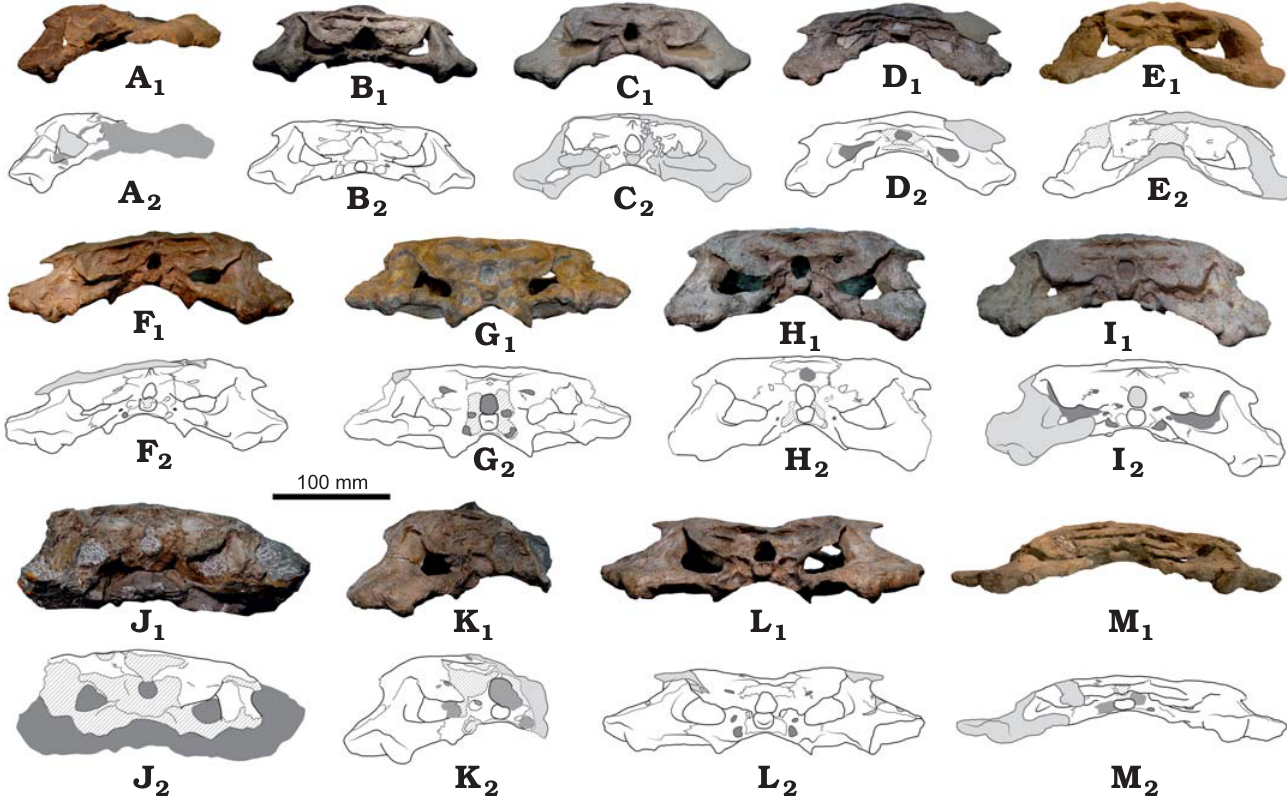
Fig. 5. Skulls of simosaurid sauropterygian Simosaurus gaillardoti Meyer, 1842 from the Ladinian, Middle Triassic of southwestern Germany, in occipital view. A . SMNS 18274. B . SMNS 16767. C . SMNS 56288. D . SMNS 59366. E . MHI 1366. F . SMNS 50714. G . GPIT/RE/09313. H . SMNS 10360. I . SMNS 16363. J . SMNS 59943. K . SMNS 18637. L . SMNS 50715. M . MHI 1833. Photographs (A 1 –M 1 ), schematic interpretations (A 2 –M 2 ). Light grey, plaster; dark grey, matrix; grated areas, broken or altered bones; dashed lines, limits of broken bones; thin grey lines,